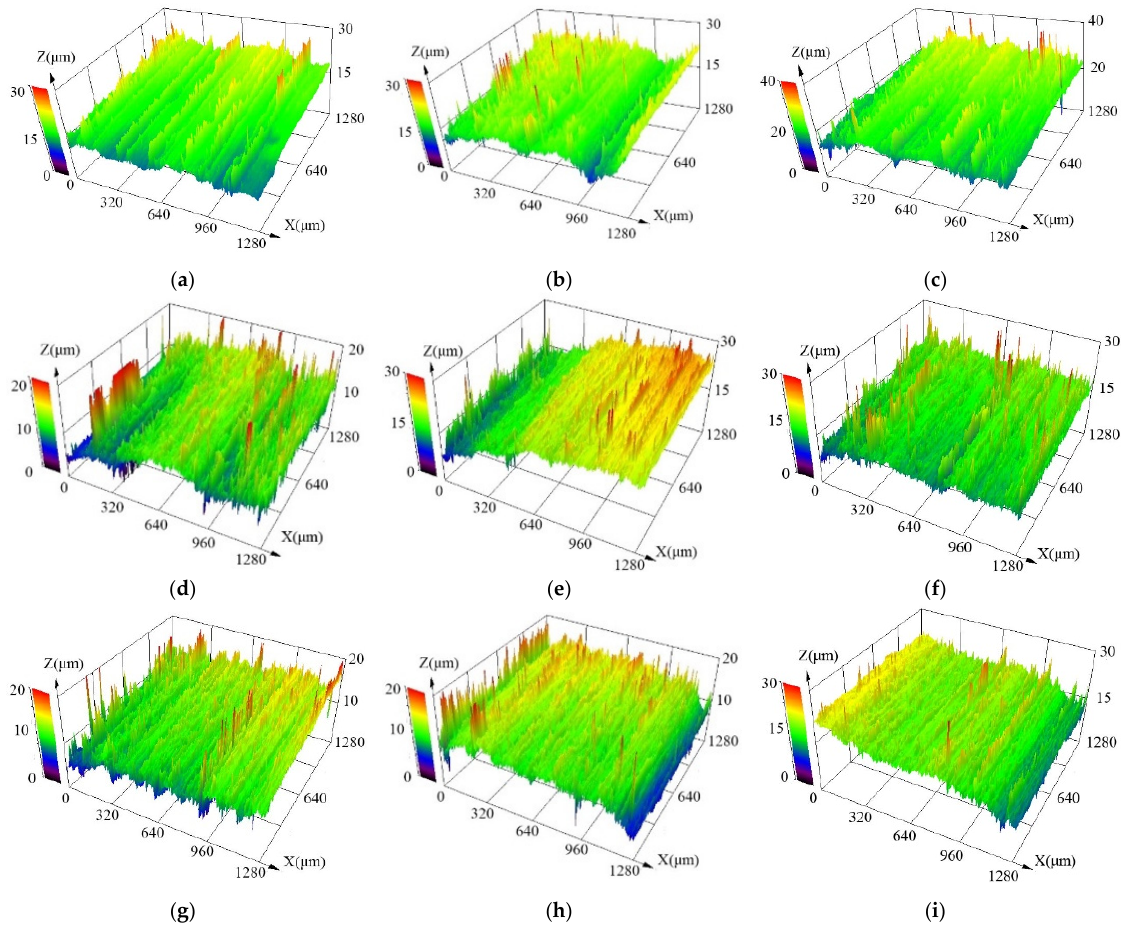
Figure 5. Three-dimensional surface morphology in the middle area of AISI 4145H steel after being abraded by the slurries with mixed abrasives: talc and quartz ( a – c ), dolomite and quartz ( d – f ), and fluorite and quartz ( g – i ). The slurries in ( a ), ( d ) and ( g ) contains 5 wt.%, ( b ), ( e ) and ( h ) 20 wt.%, and ( c ), ( f ) and ( i ) 40 wt.% of the mixed abrasives. Figure 5d–f exhibits the three-dimensional morphology in the middle area of the specimens after the wear tests with slurries containing different mass fractions of the mixed abrasives of dolomite and quartz. The measured surface roughness of the abraded samples is presented in Table 9. As is seen, compared with the case with talc and quartz, the surface roughness of the present samples with dolomite and quartz increased sharply, and the values of the surface roughness in this group of samples are all greater than 10 μ m, much higher than that of the pristine samples, revealing a strong microcutting effect for the samples. As the mass fraction of the mixed abrasives in the slurries increases, the roughness for all areas on the sample surfaces generally decreases. Moreover, when the abrasive mass fraction is 5 wt.%, the surface roughness of the sample decreases in turn from the starting area, the middle area, to the end area. However, when the abrasive mass fraction is more than 20 wt.%, the surface roughness of the sample increases in turn from the starting area, the middle area, to the end area.